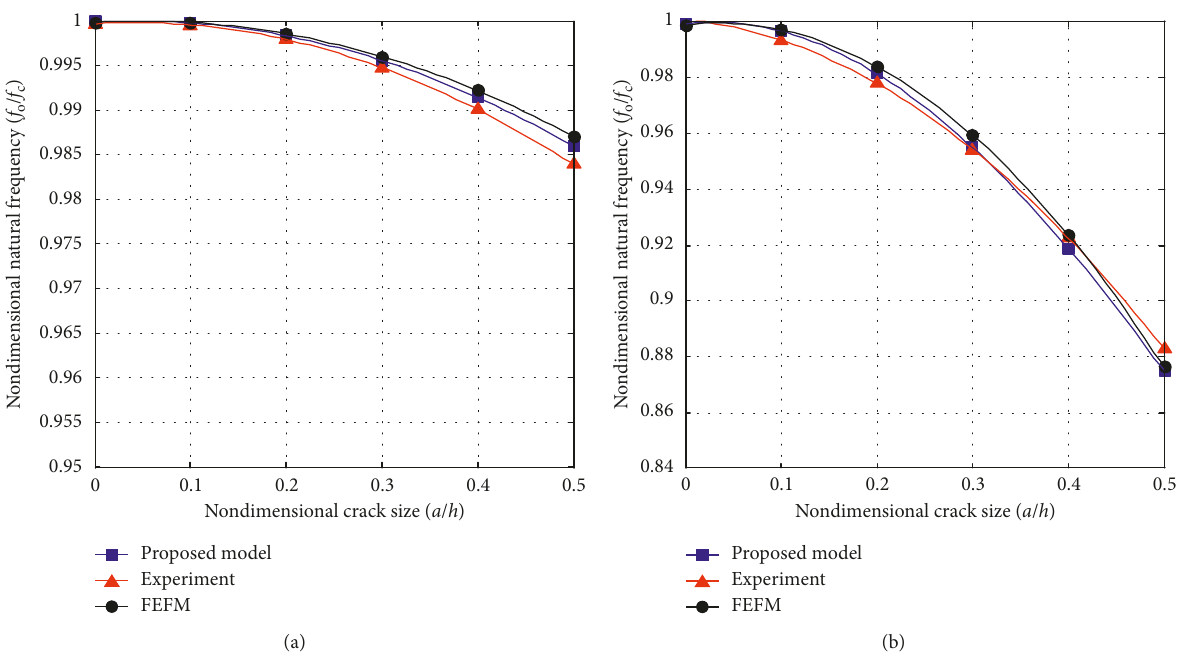
Figure 6: Comparison of the experimental natural frequencies with the FEFM and proposed model results for crack position X � 200mm: (a) the first mode; (b) the second